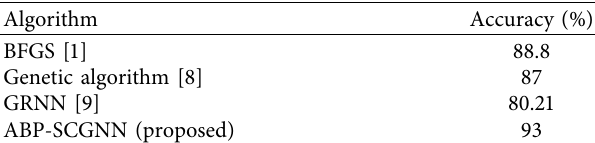
Figure 4: The MSE results of the ABP-SCGNN model at different neurons of hidden layer. Table 4: The accuracy results of the ABP-SCGNN model compared with some other